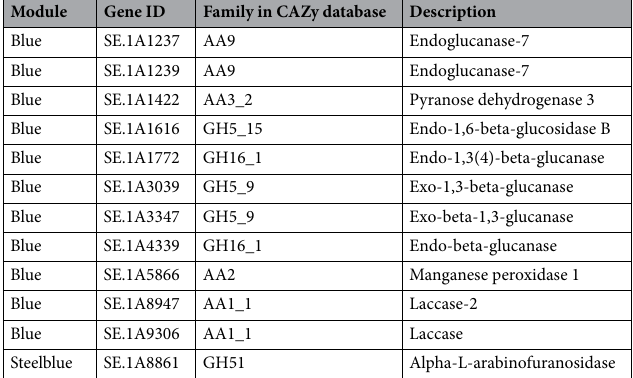
Table 1. Core genes information table.